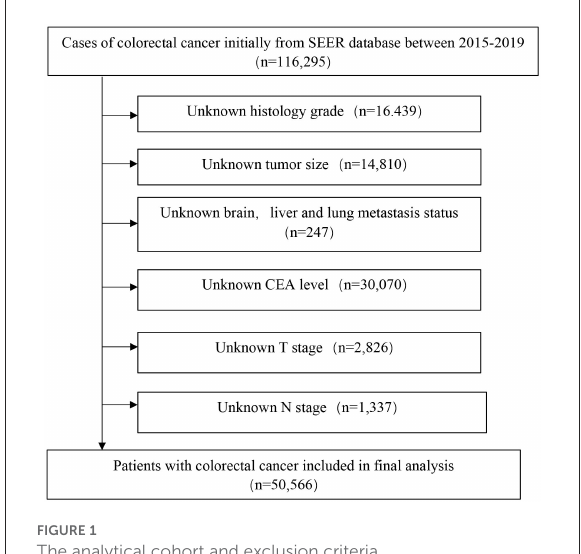
FIGURE1 The analytical cohort and exclusion